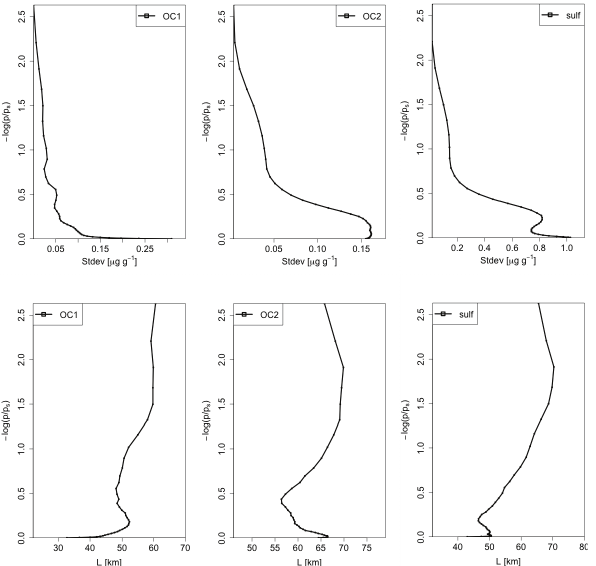
Figure 1. Vertical profiles of standard deviations (top) and horizon- tal correlation length scales (bottom) for OC 1 , OC 2 , and sulphate derived for a North American domain (see text for details). Tick mark values of − log (p/p s ) on the ordinate approximately corre- spond to values of atmospheric pressure equal to 1000, 600, 370, 220, 135, and 80hPa.